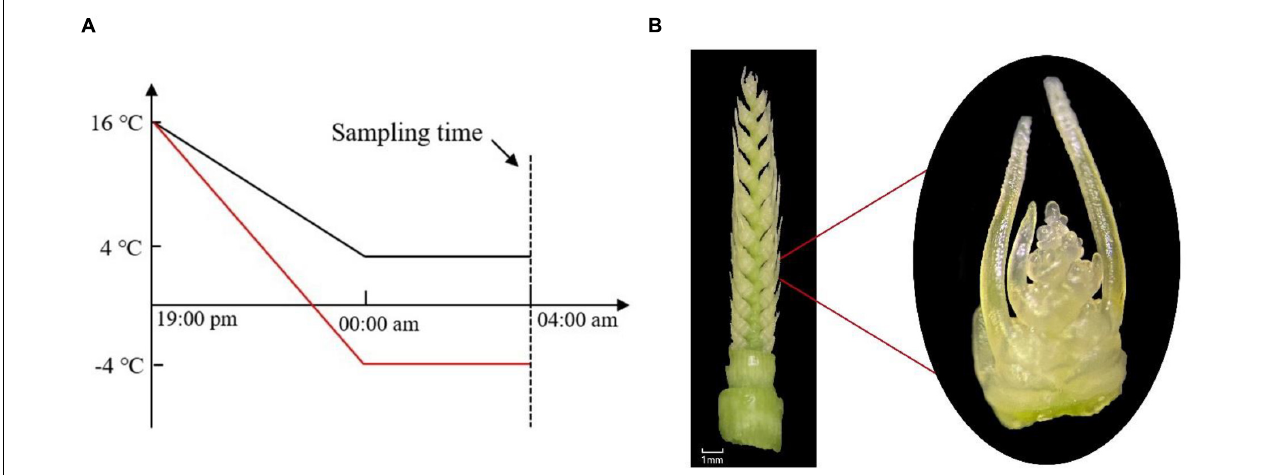
FIGURE 1 | (A) Temperature gradually declined from field conditions (16 ◦ C) to target LT (4 ◦ C, − 4 ◦ C) in 5 h, then in the next 4 h, were subjected to LT treatment. (B) Young spike of wheat at the anther connective tissue formation phase (ACFP).